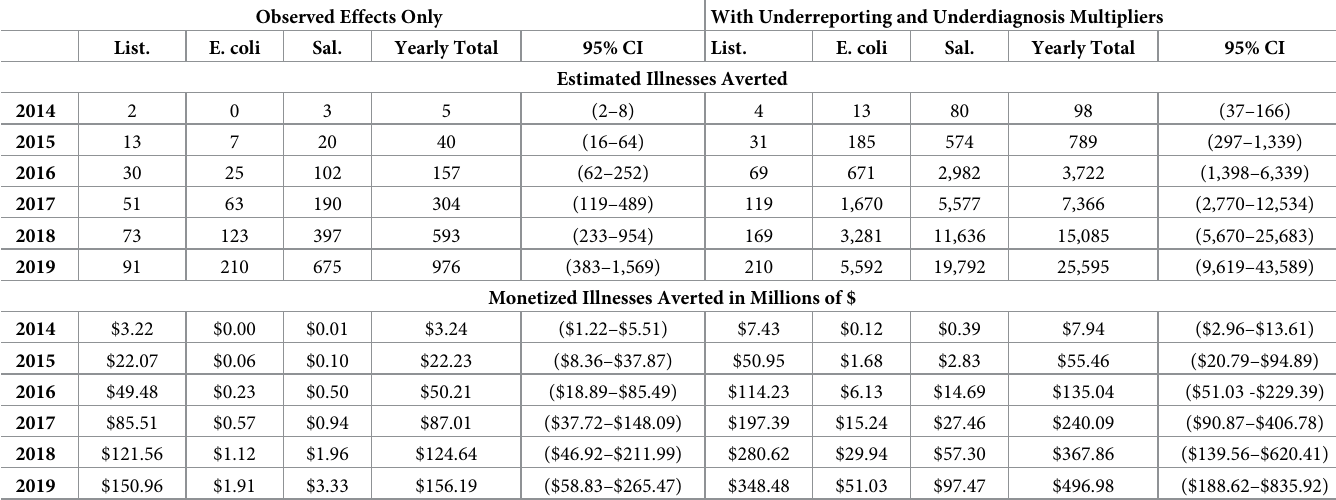
Table 4. Estimated burden of illness